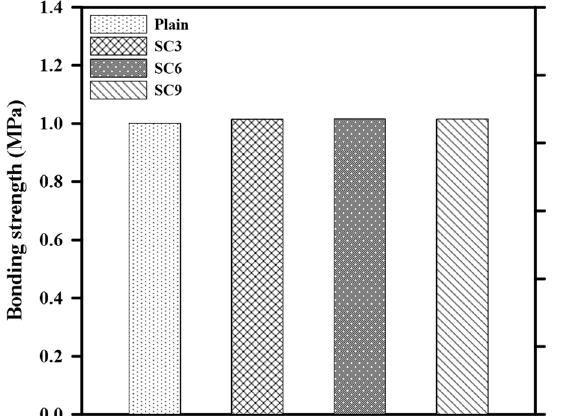
Figure 8. Bonding strength of cementitious composites.